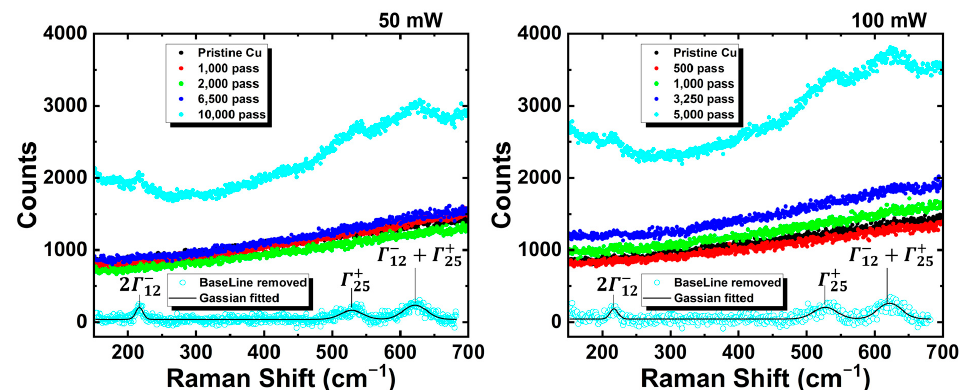
Figure 3. Raman spectra of the low ‐ fluence laser ‐ irradiated Cu substrate surface.